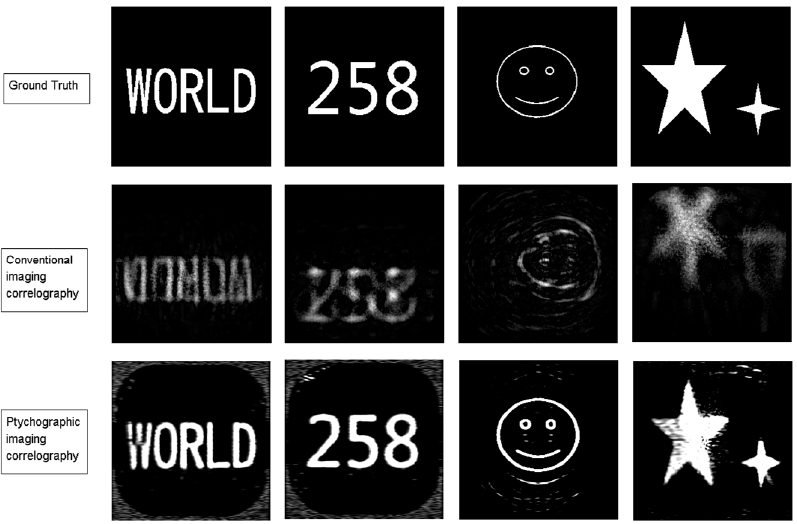
Figure 9. Reconstruction results with the conventional method and ptychographic method, respectively.